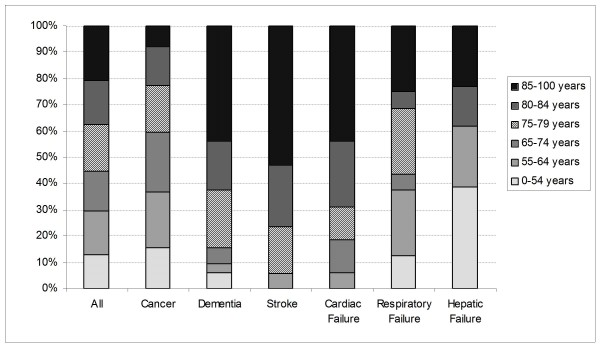
Age distributions of palliative patients by diagnostic group. The first bar represents the distribution of age of all palliative patients whatever the disease. The others display the distribution of age for the most frequent underlying diseases.